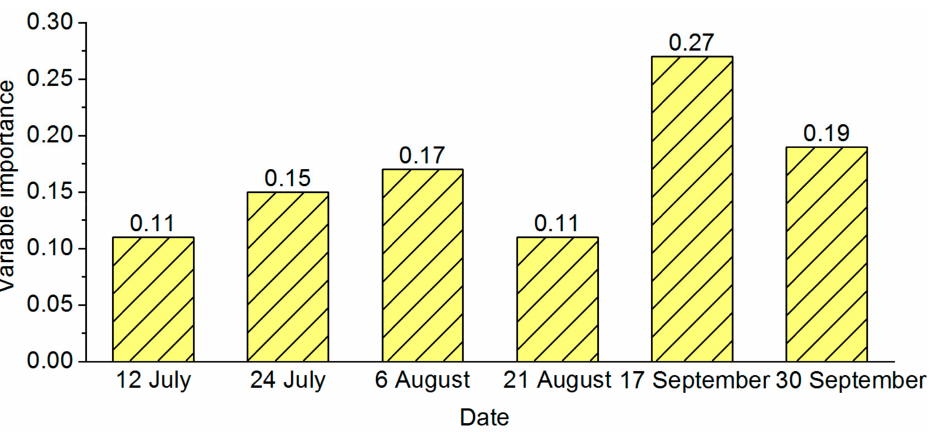
Figure 4. Variable importance of using multitemporal monitoring model based on whole growth